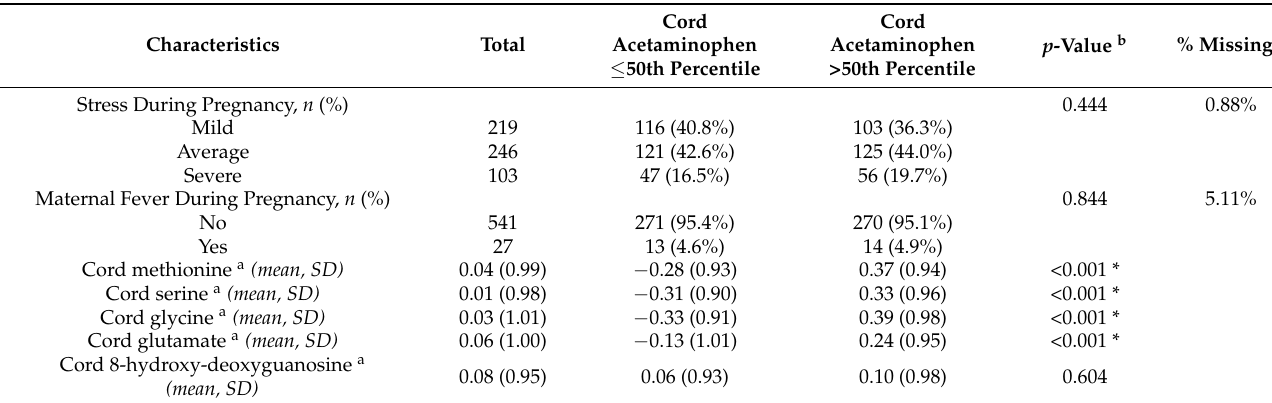
Figure 3. Association of cord plasma methionine ( A ), serine ( B ), glycine ( C ), and glutamate ( D ) with cord plasma 8-hydroxy-deoxyguanosine a . a Inverse normal transformed intensities. 3.3. Correlations of Cord Plasma Methionine, Serine, Glycine, and Glutamate with Cord Plasma Unmetabolized Acetaminophen and 8-Hydroxy-Deoxyguanosine In Figure 4A, children with cord 8-hydroxy-deoxyguanosine levels >50th percentile compared to below appear to have higher risk of ADHD for each increase in acetamino- phen level. Further, children with cord acetaminophen levels >50th percentile compared to ≤50th percentile appear to have a higher risk of ADHD for each increase in 8-hydroxy- deoxyguanosine level (Figure 4B). This finding is consistent for both males (Figure 4C) and females (Figure 4D), although females have an overall lower risk of ADHD. Table S1 demonstrates that children with cord acetaminophen >50th percentile had significantly higher odds of ADHD when cord 8-hydroxy-deoxyguanosine levels were ≤50th percentile (OR: 2.21, 95% CI (1.37, 3.58), p = 0.001) and even higher odds when 8-hydroxy-deoxygua- nosine was >50th percentile (OR: 2.38, 95% CI (1.49, 3.82), p < 0.001) compared to children with both cord acetaminophen and 8-hydroxy-deoxyguansoine levels ≤50th percentiles